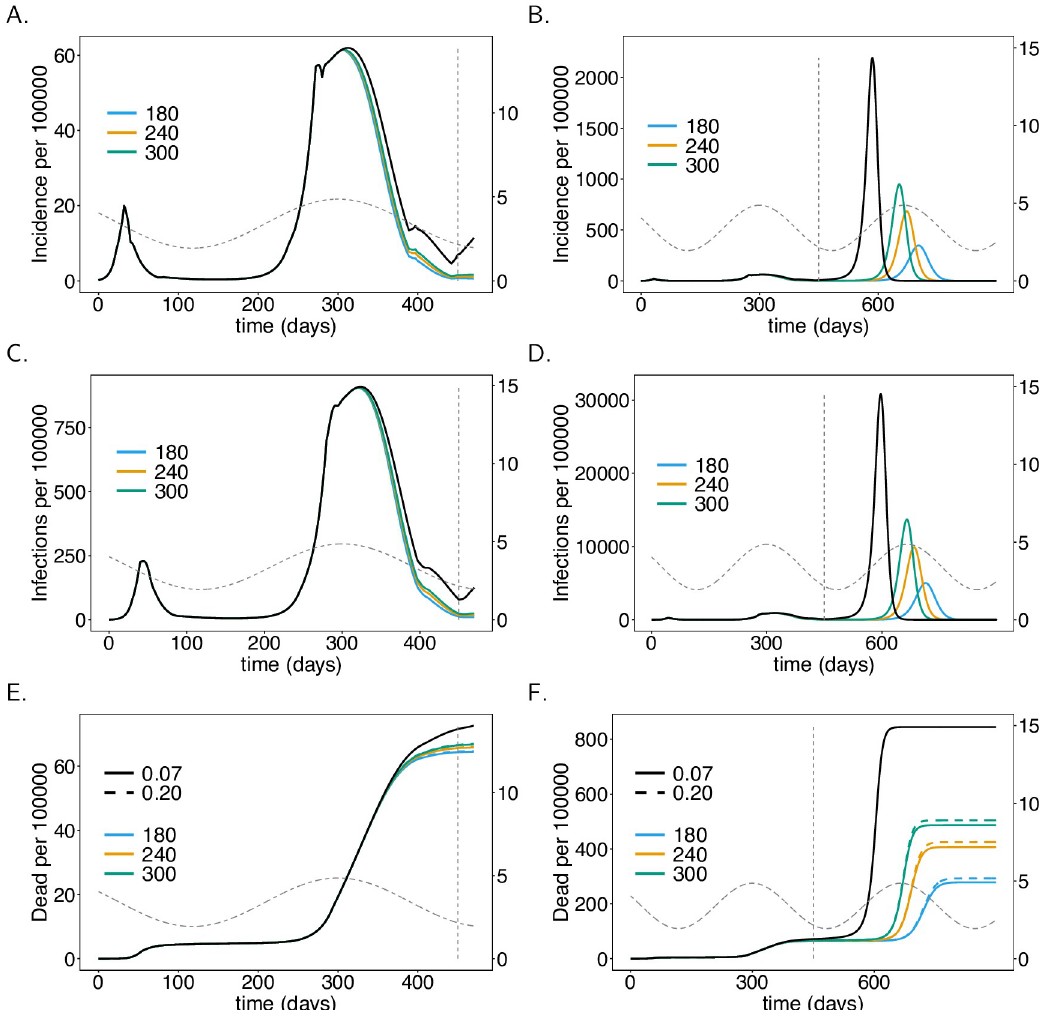
Fig 6. Vaccination rate. As Fig 4, but for different vaccination rates (colors), i.e., average waiting times (shown in legend) to get